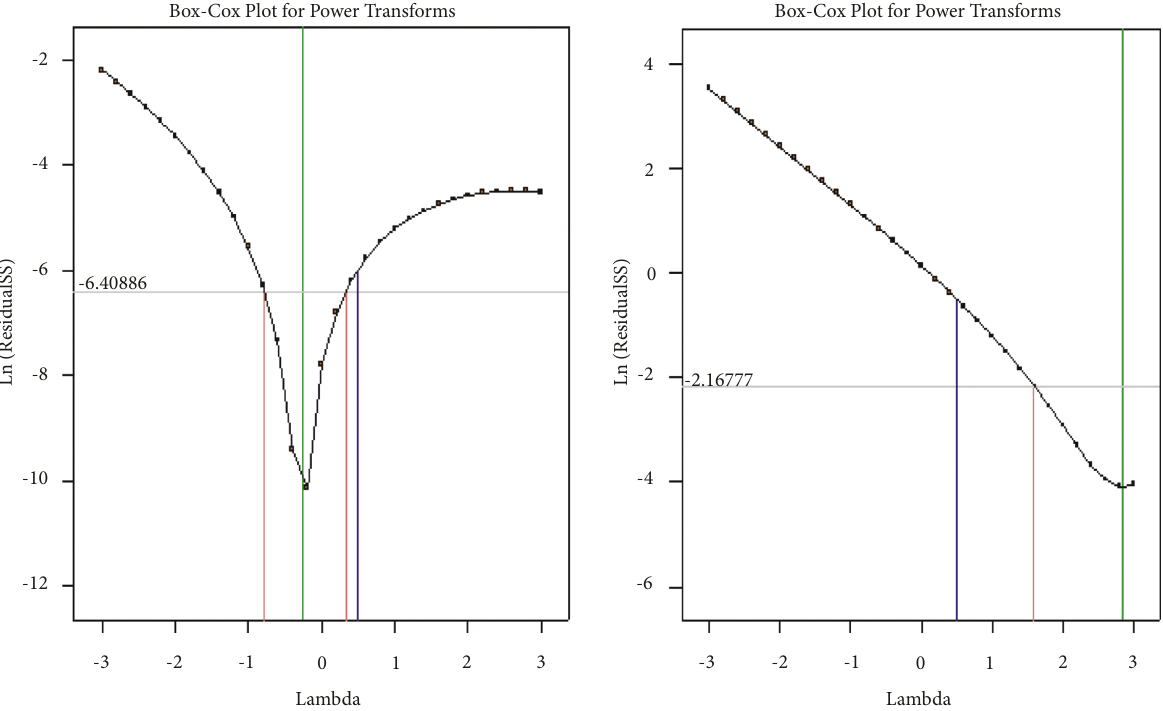
Figure 12: Box-cox plots for power